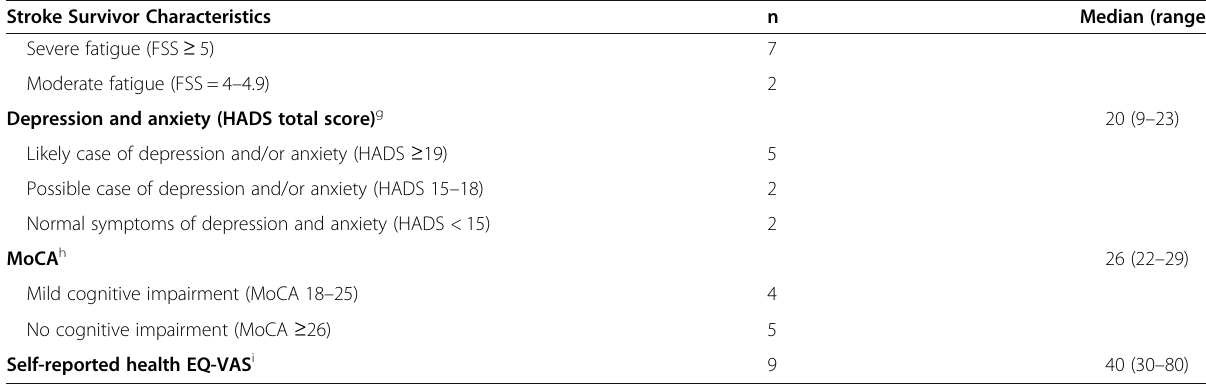
Table 2 Demographics, clinical characteristics and health-related quality of life of the stroke survivors with PSF (individual interview participants) (Continued)